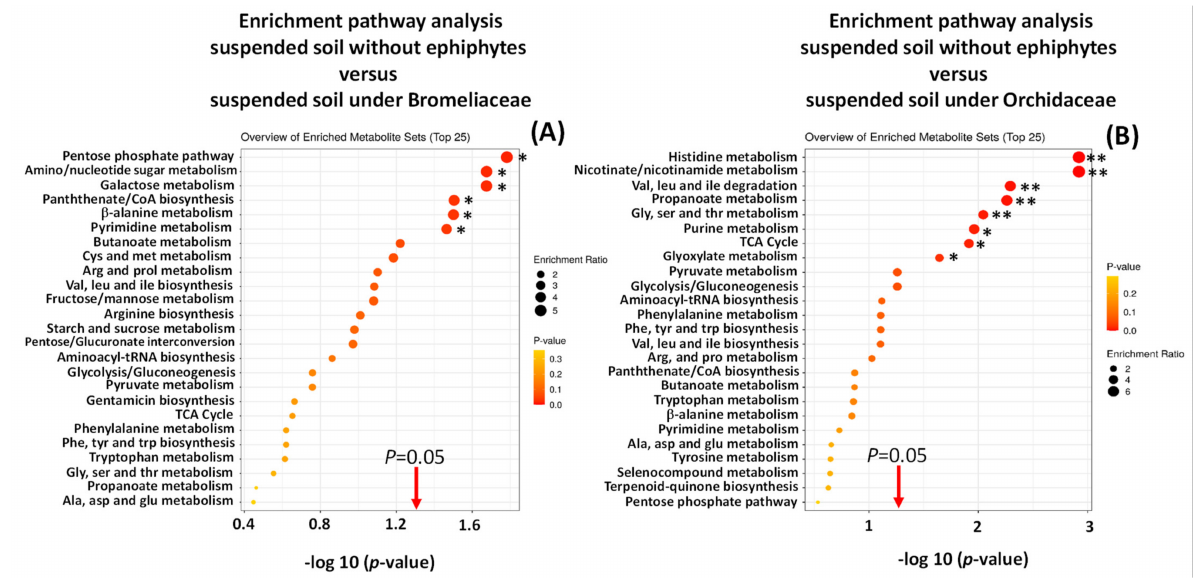
Figure 6. Enrichment pathway analysis of metabolomic profiles of suspended soils associated with Bromeliaceae ( A ) and Orchidaceae ( B ) compared with non-epiphyte soils. * p < 0.05, ** p <